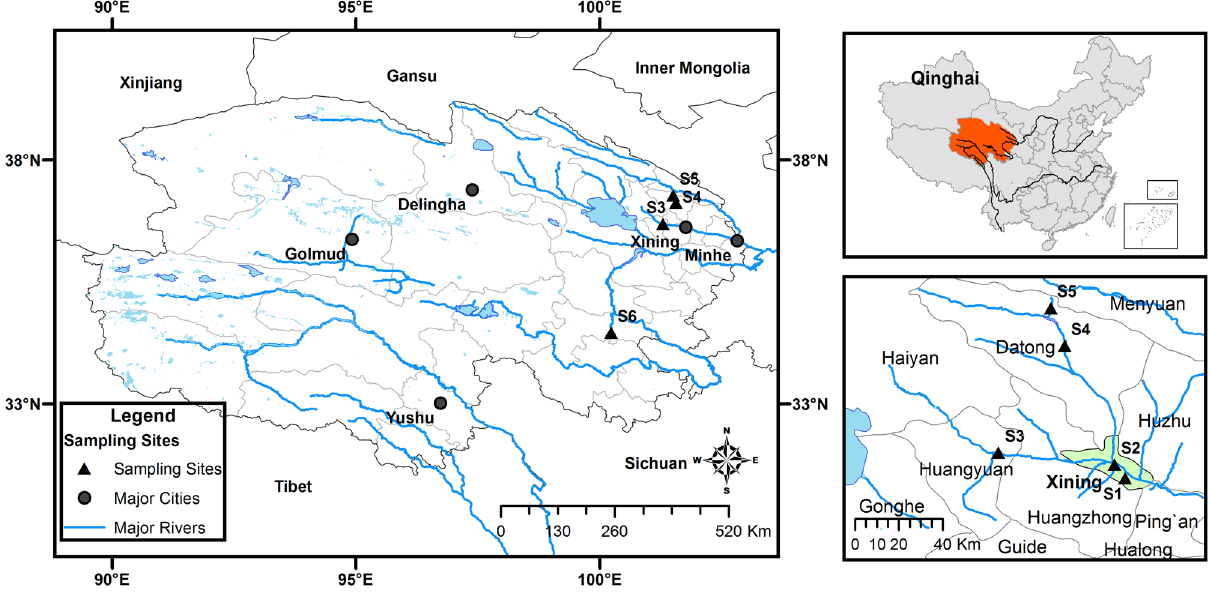
Figure 3. Sampling sites in Qinghai Province, P.R. China. S1-Baide slaughterhouse, S2-Xining WWTP, S3-Huangyuan WWTP, S4-Baoku River, S5-Chahan River, S6-Guoluo River (Modified by ArcGIS